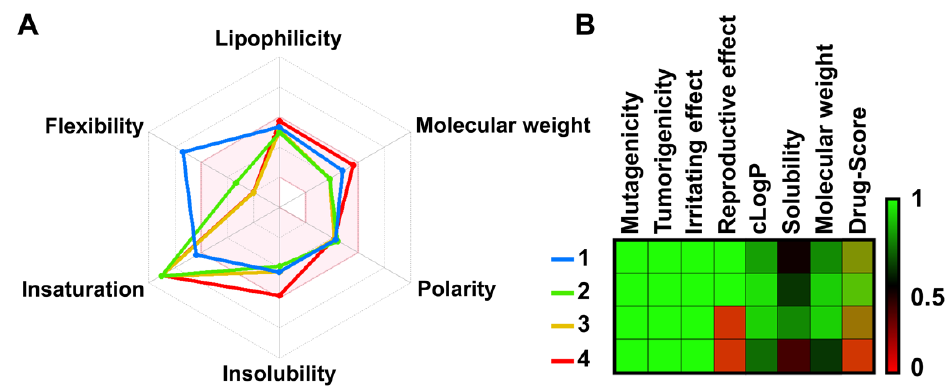
Figure 2. ( A ) Bioavailability radar was computed by 2D chemical structures according to their physicochemical properties such as flexibility, lipophilicity, molecular weight, polarity, water solubility, and saturation. An accepted region is represented as a pink area. ( B ) The toxicity risks and pharmacological properties of designed compounds were predicted by OSIRIS Property Explorer. Each value ranges from 0 to 1 (red, black, green).